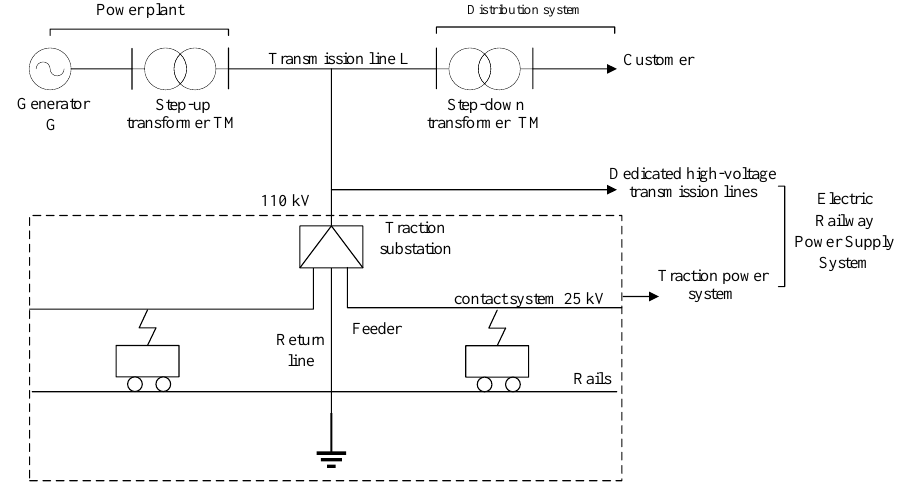
Figure 1. Electric railway power supply system.